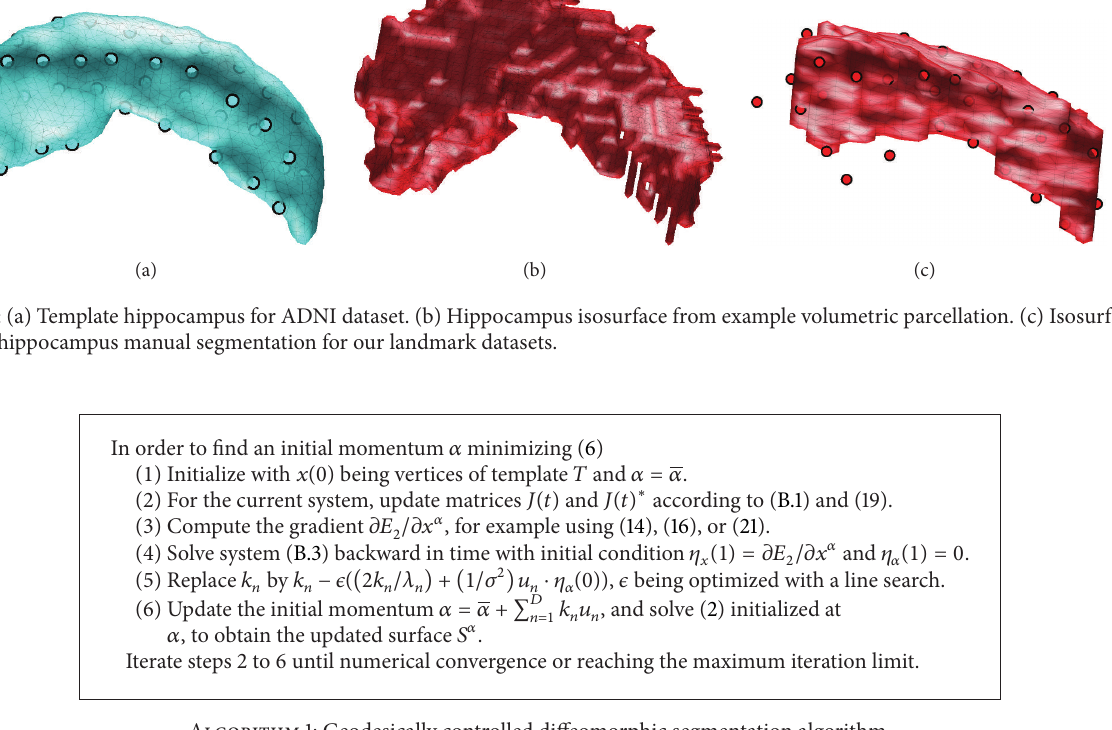
Algorithm 1: Geodesically controlled diffeomorphic segmentation